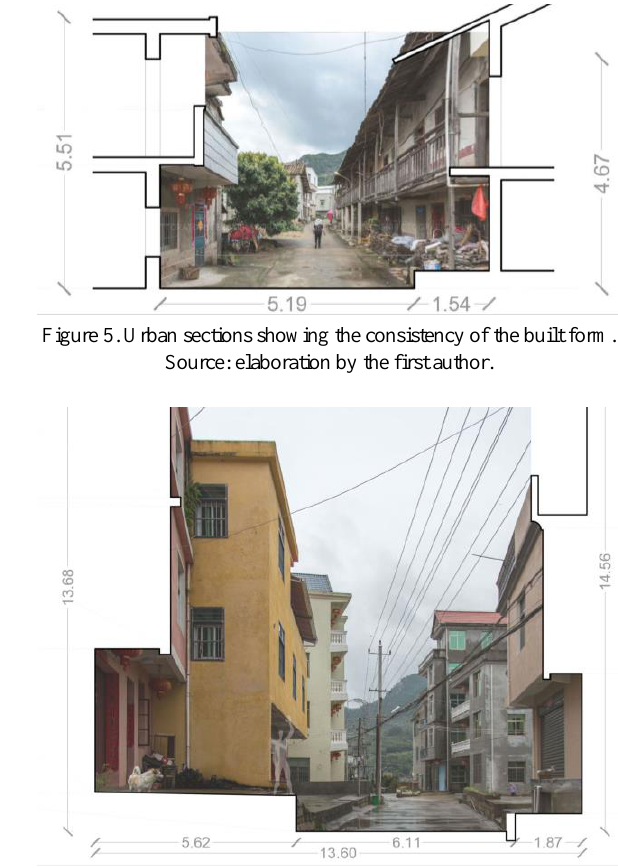
Figure 6. Urban sections showing the consistency of the built form.